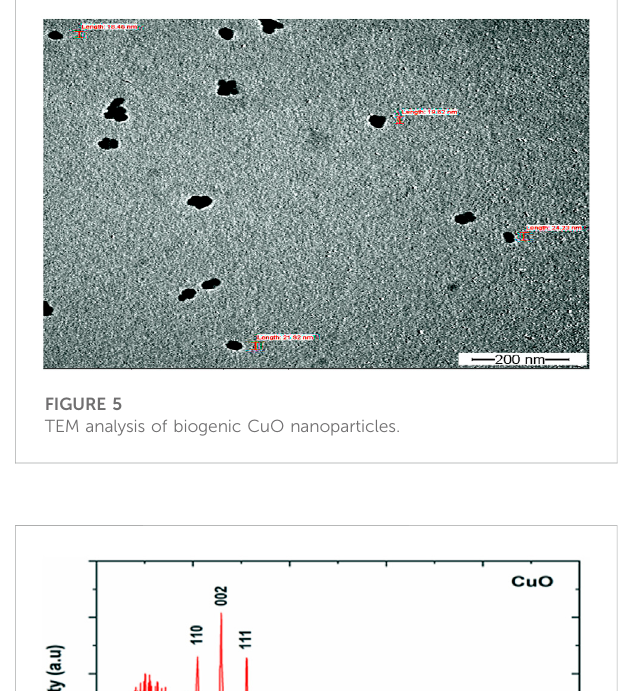
FIGURE 6 XRD analysis of bacterial assisted CuO nanoparticles.